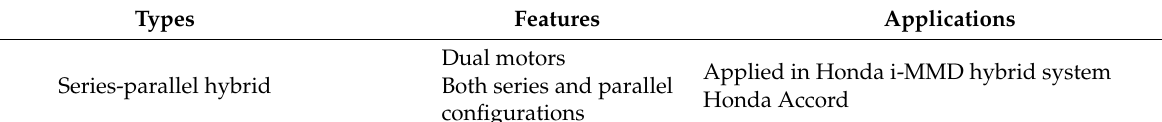
Table 3. Characteristics and applications of combined hybrid configurations [15–18].